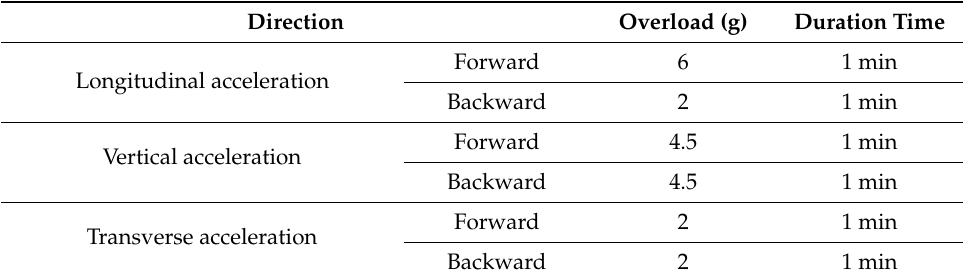
Figure 19. Relative signal change of all the paths after overload tests. ( a ) Relative amplitude change. ( b ) Relative phase change.